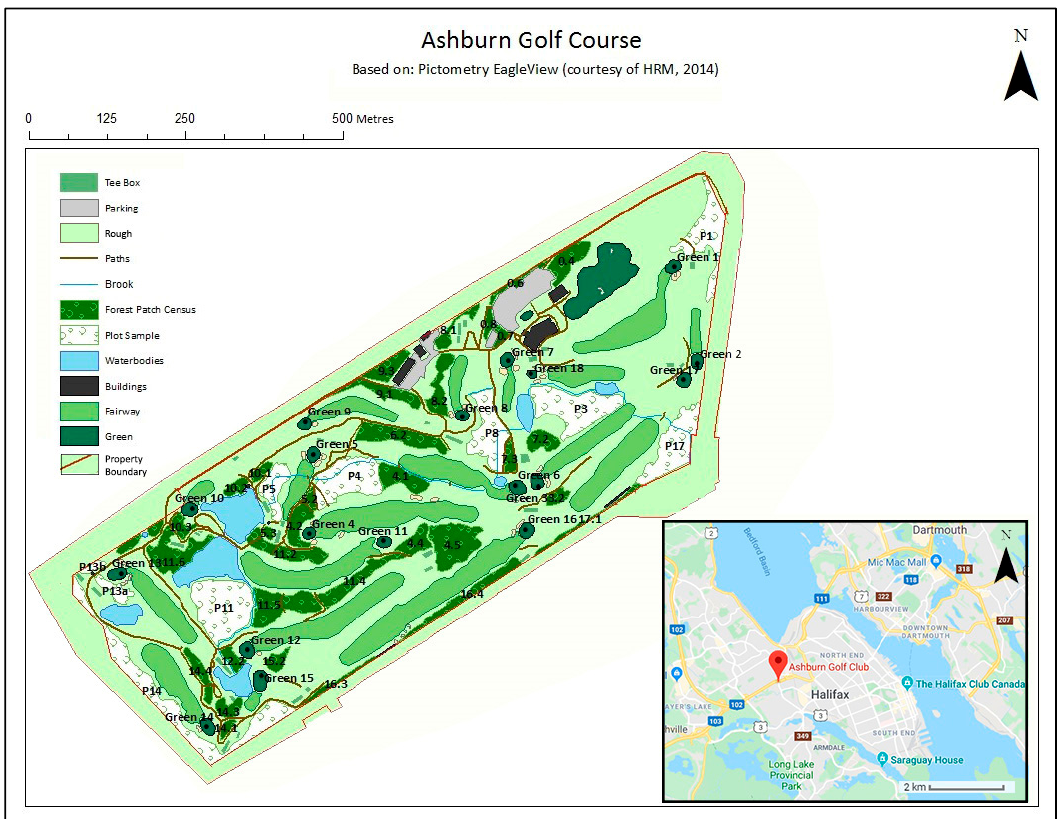
Figure 2. Overview map of OAGC; red outline reflects property boundaries. Inset map provided to illustrate the course’s location within the HRM. Source: ©2019 Google. Table 1. Description of crown condition ranking system. Adapted from Neighbourwoods protocol